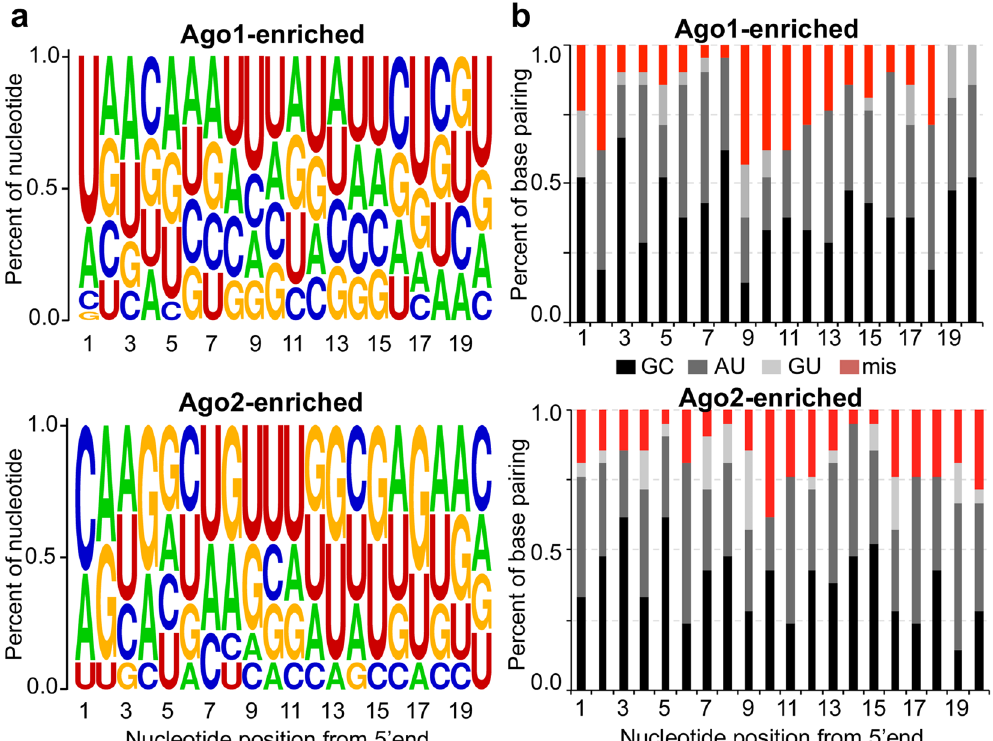
Figure 3. Structural determinants of the Ago1 and Ago2-enriched miRNAs. ( a ) Nucleotide composition of miRNAs that displayed strong preferential ( > 70%) association with Ago1 or Ago2. The y axis is the frequency of each nucleotide at each position. ( b ) Median base pairing at each position of all miRNAs that showed a highly biased ( > 70%) association with Ago1 or Ago2. Bulges on each strand were counted as mismatches